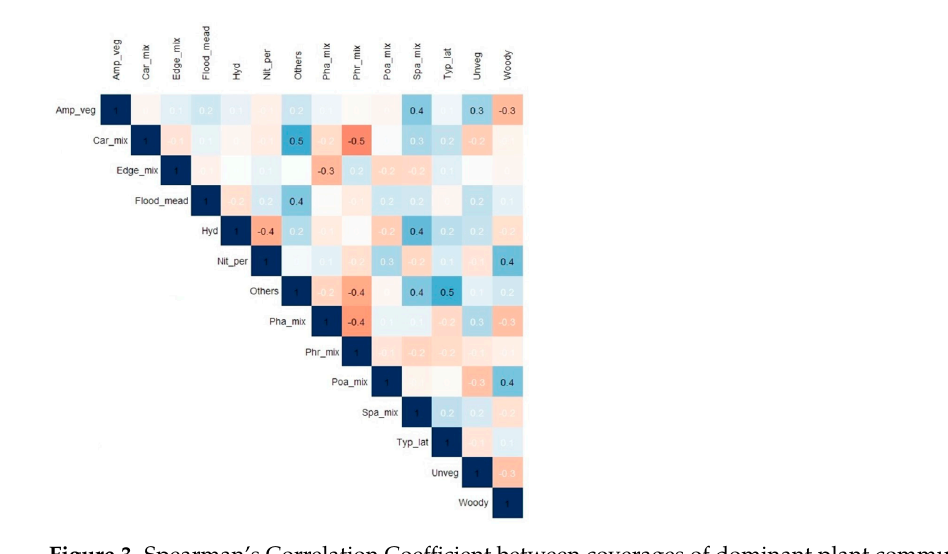
Figure 3. Spearman’s Correlation Coefficient between coverages of dominant plant communities of 14 kettle holes over five years; significance level = 0.05; significant values = black, insignificant values = white; color scale represents strength (between 0 and ± 1) and direction (+, − ) of Spearman